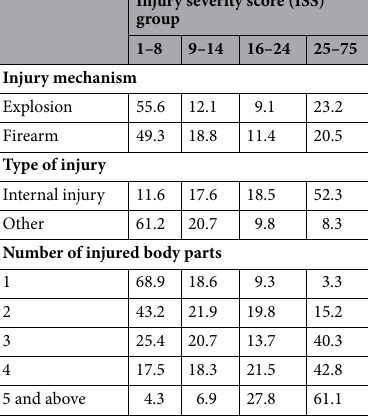
Table 4. Distribution of injury severity score by injury mechanism, nature of injury and number of injured body areas. The sum of the percentages in each row is 100%. Body region groups are defined as: TBI, other head, VCI/SCI, chest, abdomen, pelvis, back and buttock, upper extremities, lower extremities and